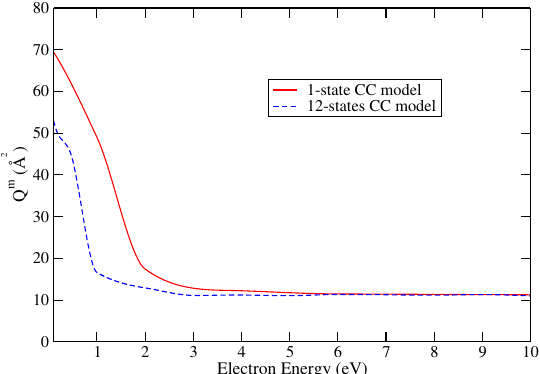
Figure 8. Born-corrected momentum-transfer cross sections.